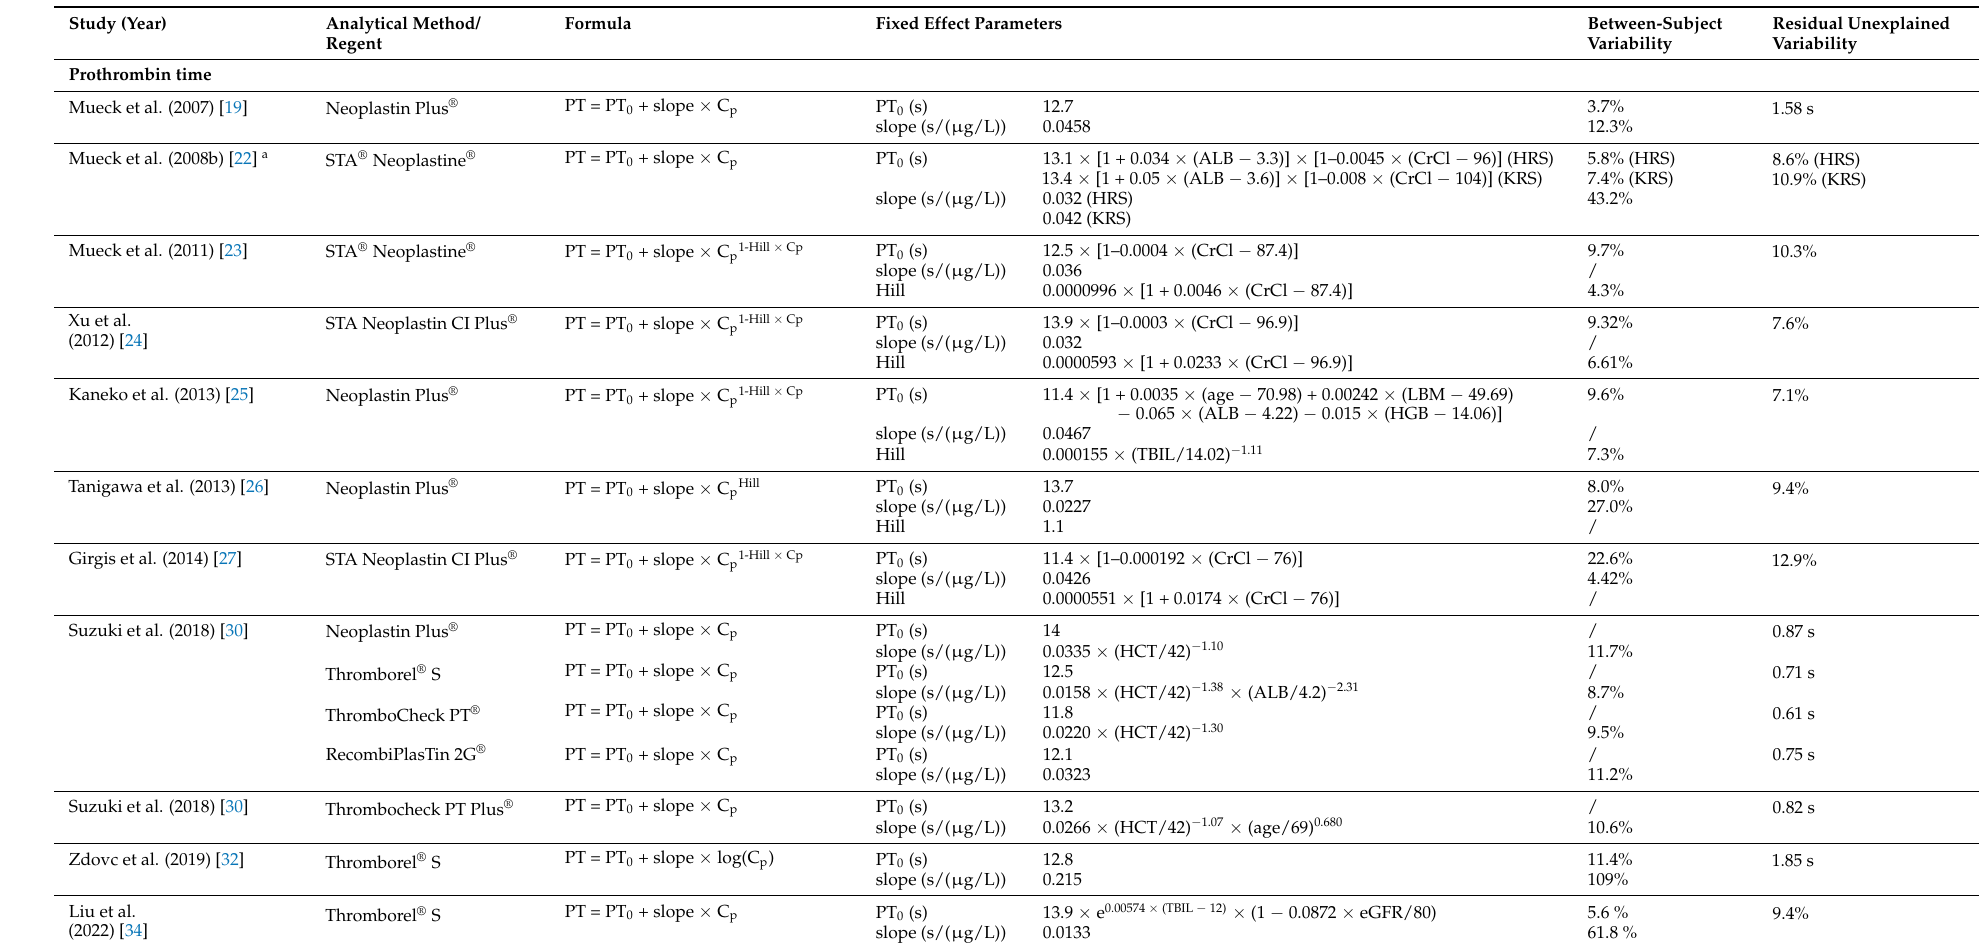
Table 3. Final population pharmacodynamic parameters of included